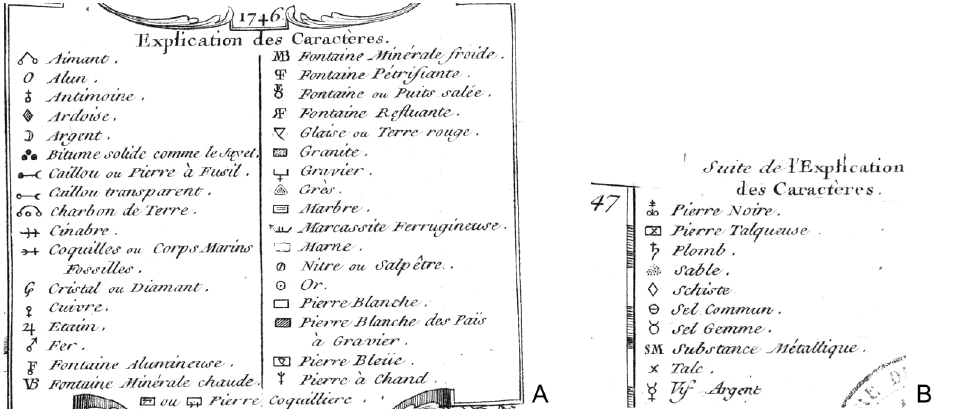
Fig. 5. The legend of the map by J.-É. Guettard Carte minéralogique où l’on voit la nature et la situation des terreins … printed in 1751 (the collection of the Bibliothèque nationale de